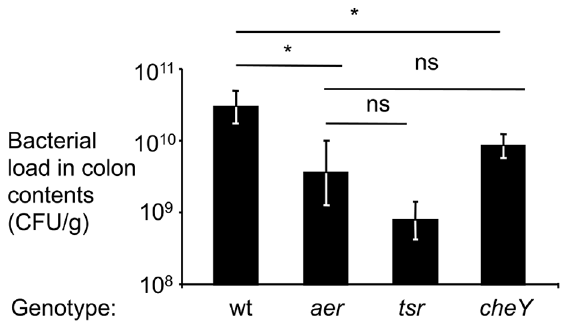
Figure 4. Aer and Tsr boost growth in the mouse colitis model. Groups of streptomycin pre-treated mice were inoculated with the S . Typhimurium wild-type strain (wt), an aer mutant ( aer ), a tsr mutant ( tsr ) or a cheY mutant ( cheY ) and colon contents were collected for analysis four days after infection. The numbers of animals ( N ) used in each group is indicated in Figure S4A. Bacterial load in the colon contents of infected mice are shown. Bars represent geometric means 6 standard error. *, P , 0.05; ns, not